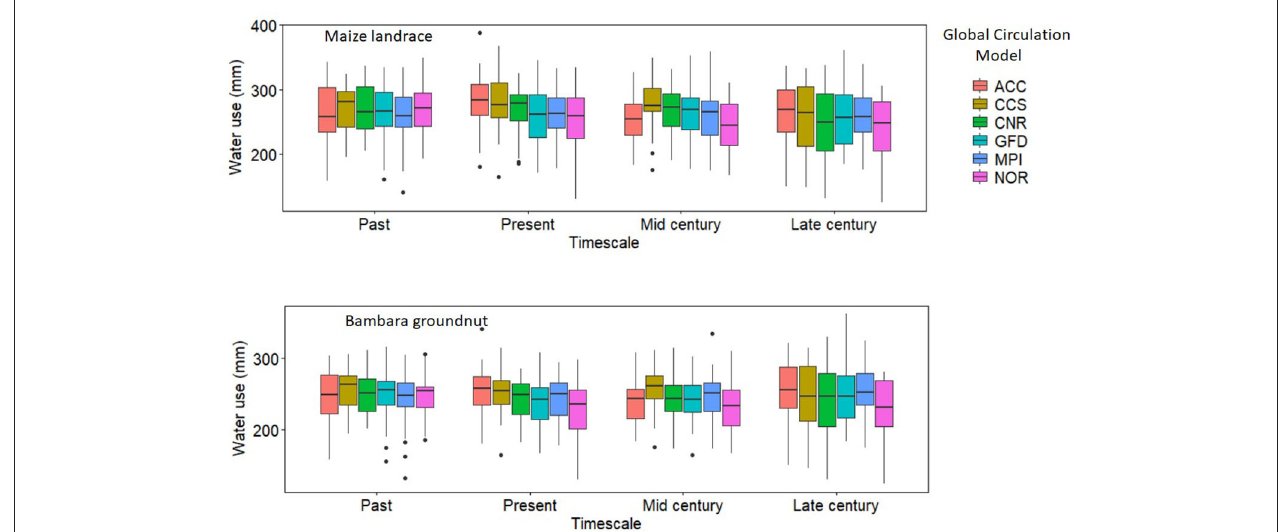
FIGURE 5 | Calculated water use (mm) of maize landrace and bambara groundnuts from soil evaporation (Es), crop water use (Ep) as simulated by APSIM across the six GCMs (ACC, CSS, CNR, GFD, NOR, and MPI) for each timescale (past, present, mid-century, and late-century). The effect of timescale on maize landrace water use - F -statistic: 2.989 on 3 DF, P = 0.03. The effect of GCM on maize landrace water use - F -statistic: 2.6392 on 5 DF, P = 0.02. The effect of GCM on bambara groundnut water use - F -statistic: 3.315 on 5 DF, P =